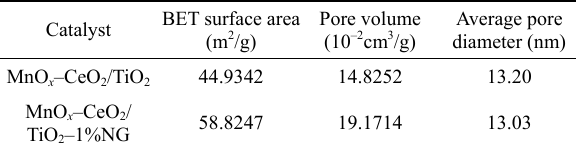
Porous structure parameters of MnO x